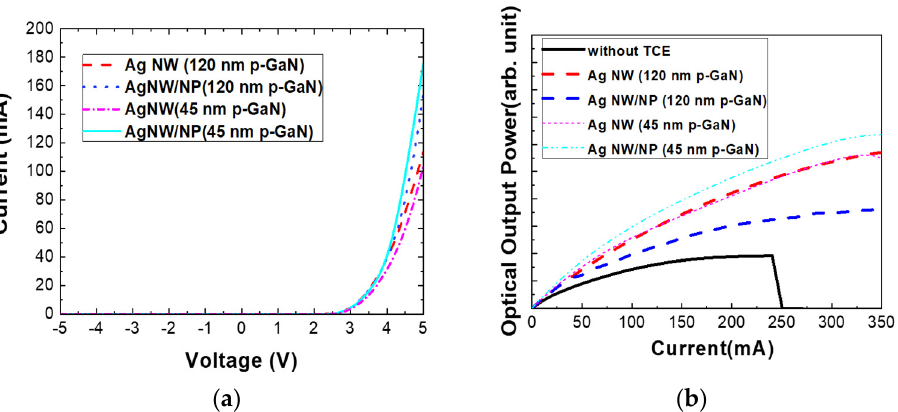
Figure 6. (a) Current–voltage characteristic and ( b ) optical output power of LED with Ag NW and NW/NP TCEs.